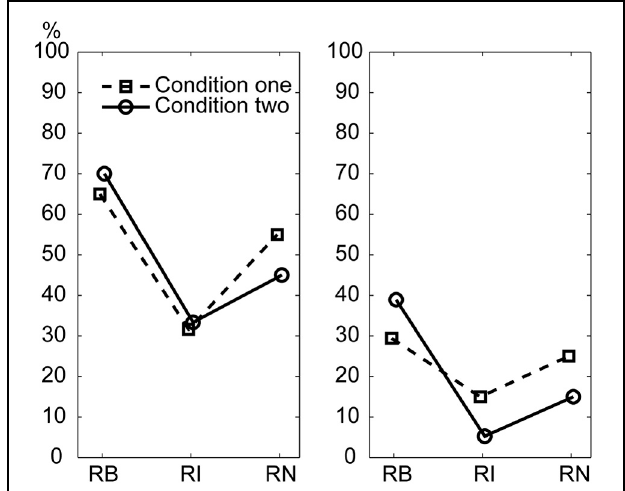
FIGURE 7 | Percentage of correctly reproduced rhythms with a 600ms beat interval. Left: subject 1; Right: subject 2. RB, RI, and RN represent rhythms formed with b inary, non-binary i nteger, and n on-integer ratios,